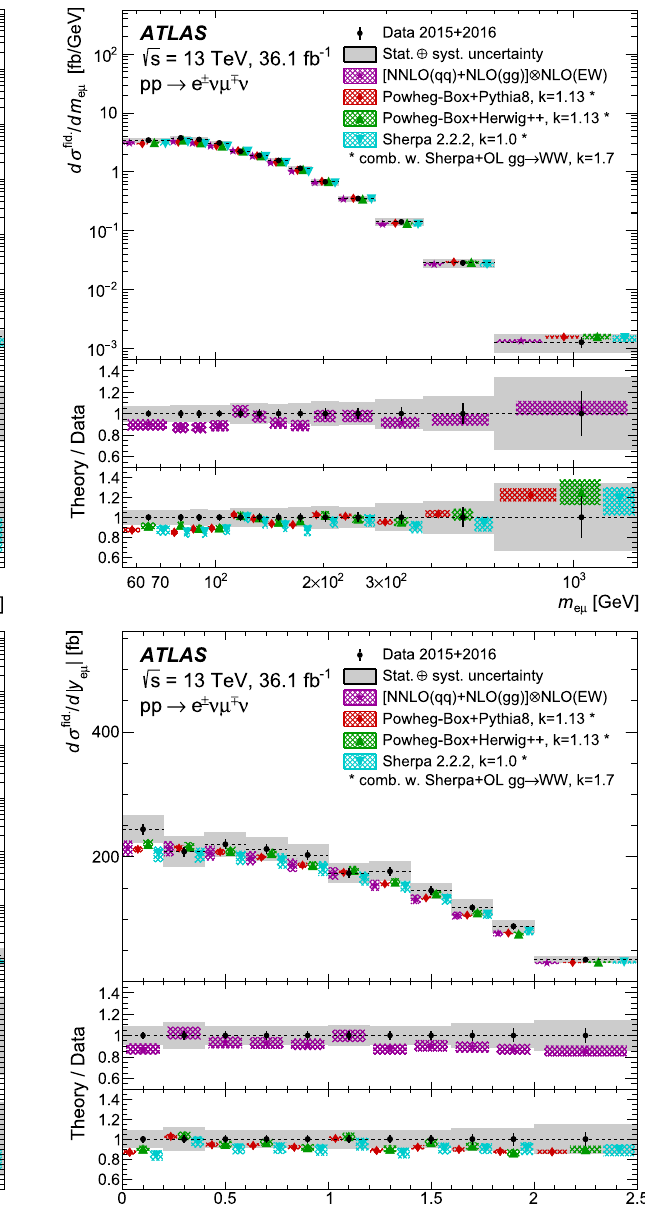
tions from Powheg- Box + Pythia 8, Powheg- Box + Herwig++ and Sherpa 2.2.2 for q ¯ q initial states, combined with Sherpa + OpenLoops , T (LO+PS) for the gg initial states. All three q ¯ q NLO+PS predictions are normalized to the NNLO theoretical prediction for the total cross- section, with the gg LO+PS contribution normalized to NLO. Theoret- ical predictions are indicated as markers with hatched bands denoting PDF+scale uncertainties Constraints on the EFT coefficients are determined by considering only one operator at a time using the unfolded ) fiducial cross-section, which was leading lepton p T ( p lead (cid:5) T identified as the unfolded distribution most sensitive to the effect of the five